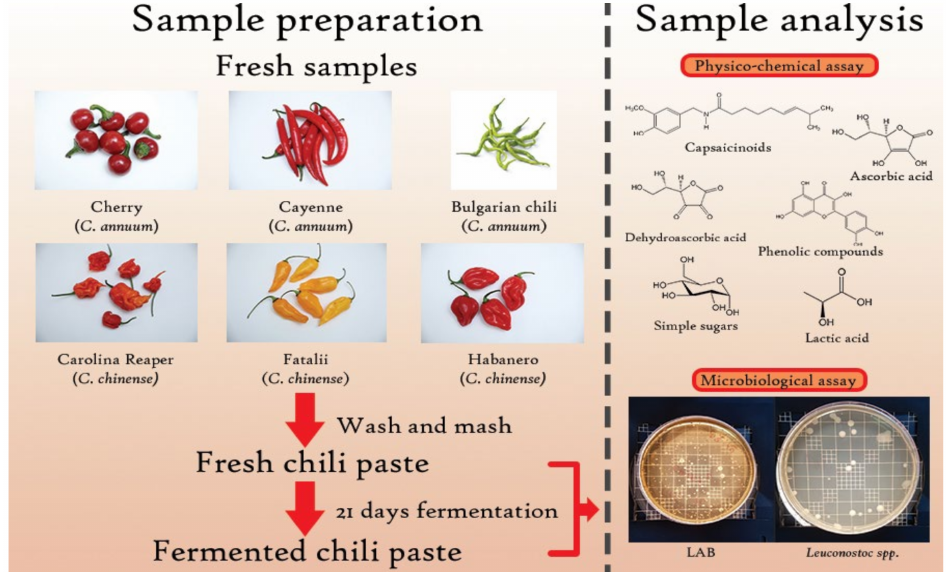
Figure 4. Experimental scheme—samples preparation and analysis. L-ascorbic acid, capsaicin and dehydro-capsaicin, gallic acid and rutin standards were procured from Sigma-Aldrich (St. Louis, MO, USA); methanol, metaphosphoric acid, and acetonitrile were obtained from Merck (Darmstadt, Germany). All reagents were of analytical